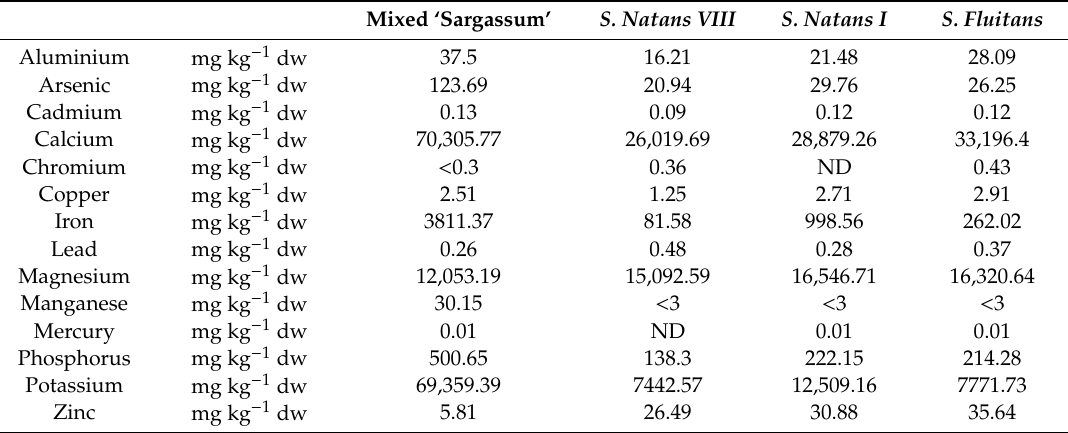
Table 5. The results of the heavy metal analysis of Sargassum inundation (‘Mixed Sargassum’) and pelagic species of Sargassum from Turks and Caicos ( n = 1) (ND = not detected)